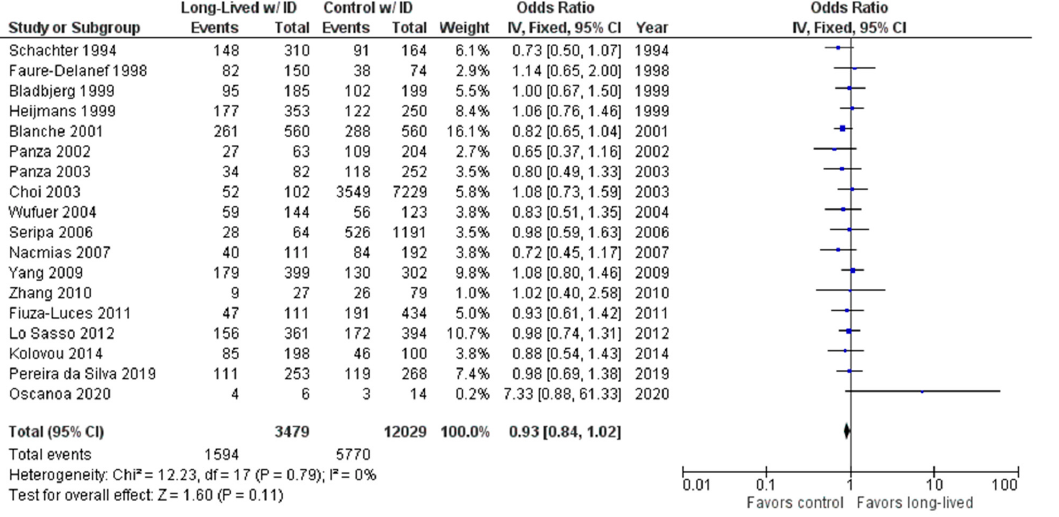
Figure 6. Comparison of ID genotype frequency in long-lived and control groups. The ages of long-lived and control groups are described in Table 1. The p -value is indicated by P in the Figure. The ID genotype was found to have an OR of 0.92 (95% CI: 0.84–1.02, p = 0.11) with no